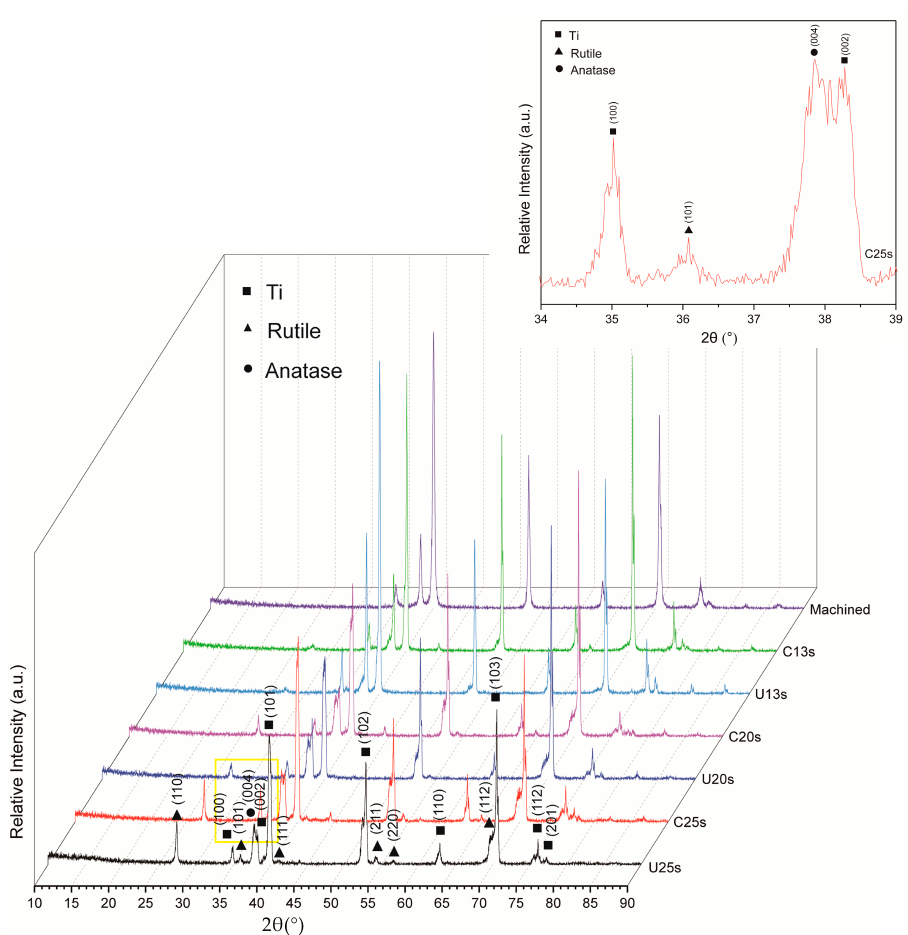
Figure 2. XRD patterns of titanium surface before and after IHT with and without ultrasonic assistance for 13–25 s. The insert diagram is an enlarged diagram for some diffraction peaks (in the yellow wireframe) in the